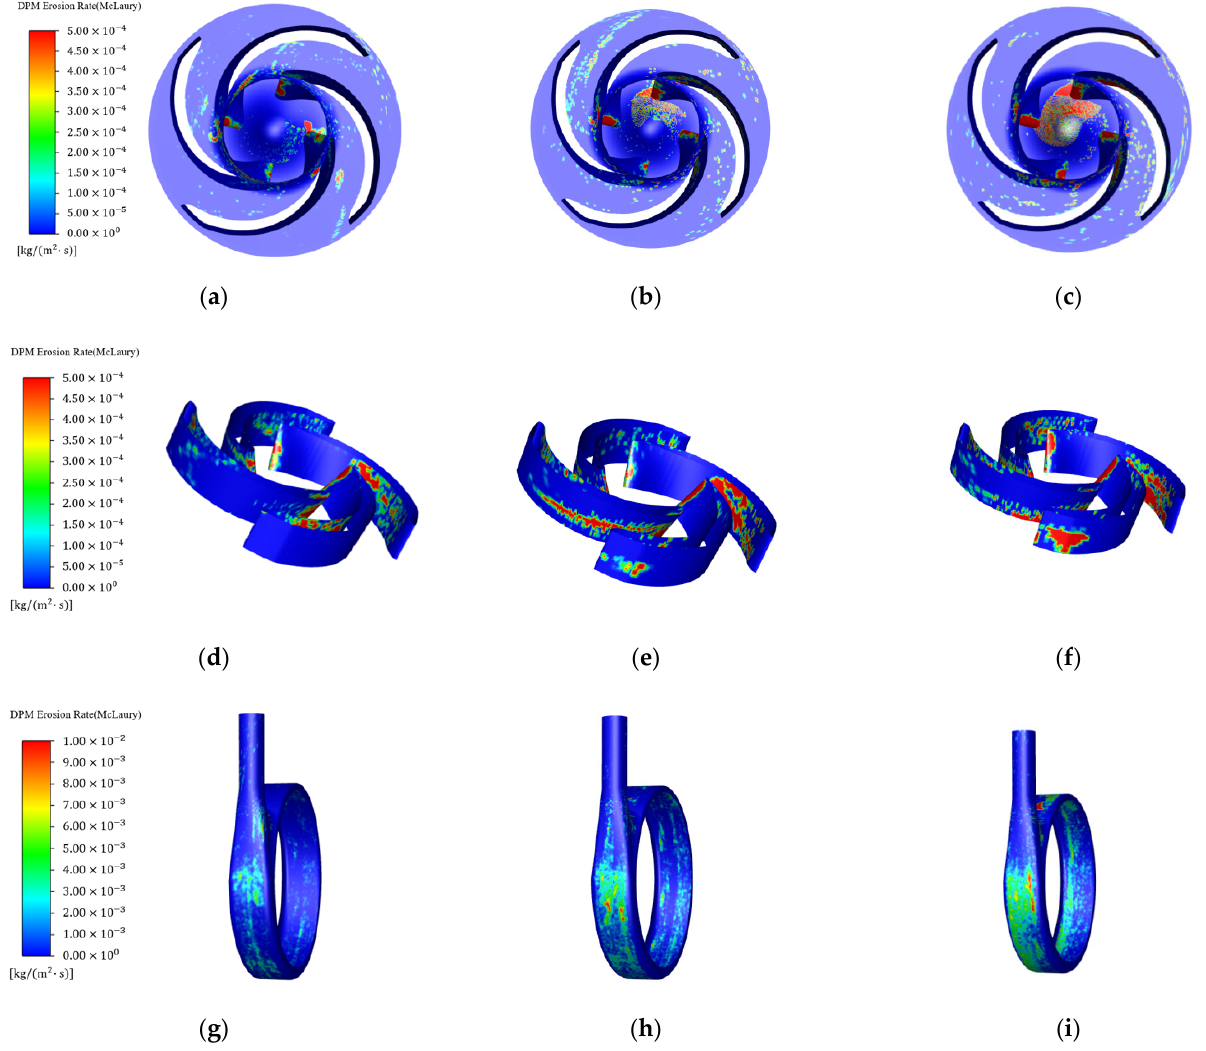
Figure 15. Wear distribution of each part at different volume flow rates: Impeller inlet: ( a ) 0.6 Q BEP ; ( b ) 1.0 Q BEP ; ( c ) 1.4 Q BEP ; Blades: ( d ) 0.6 Q BEP ; ( e ) 1.0 Q BEP ; ( f ) 1.4 Q BEP ; Volute: ( g ) 0.6 Q BEP ; ( h ) 1.0 Q BEP ; ( i ) 1.4 Q BEP .